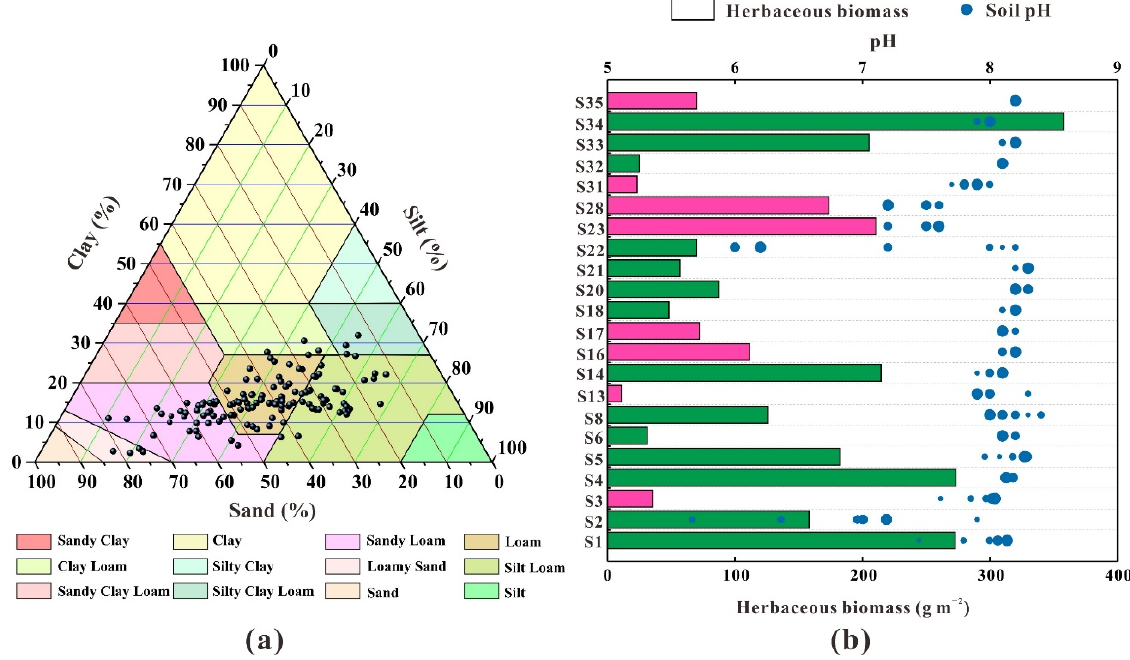
Figure 3. Characteristics of soil texture ( a ), pH and herbaceous biomass ( b ). The soil texture triangle diagram has been reported in our previous study [49]. Soil pH at different depths is displayed by bubble diagrams, where larger bubbles represent the soil samples in deeper horizons. The column in green represents forest land sites, while that in red represents non-forest land sites.